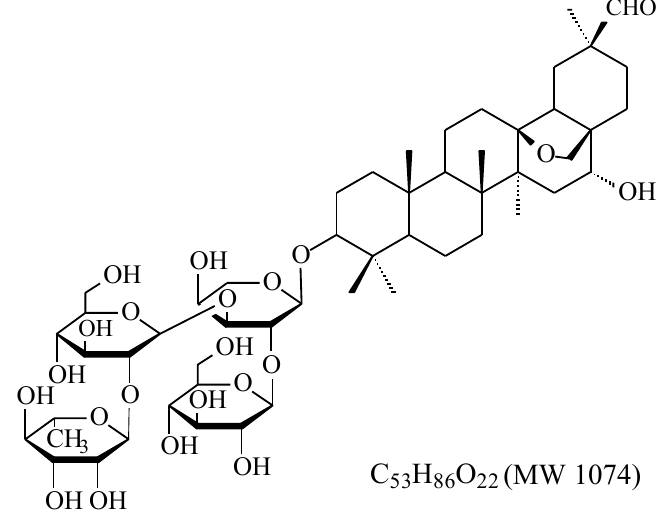
Figure 1. Chemical structures of ADS-I.